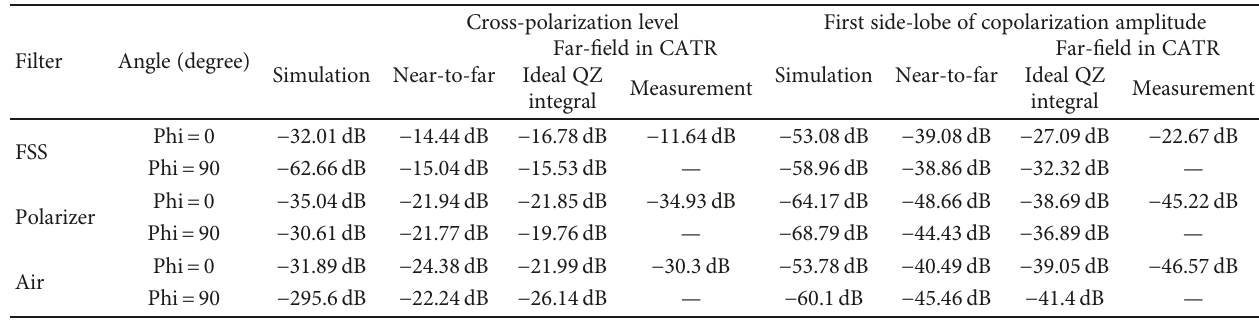
Table 4: The far- fi eld results of 324GHz